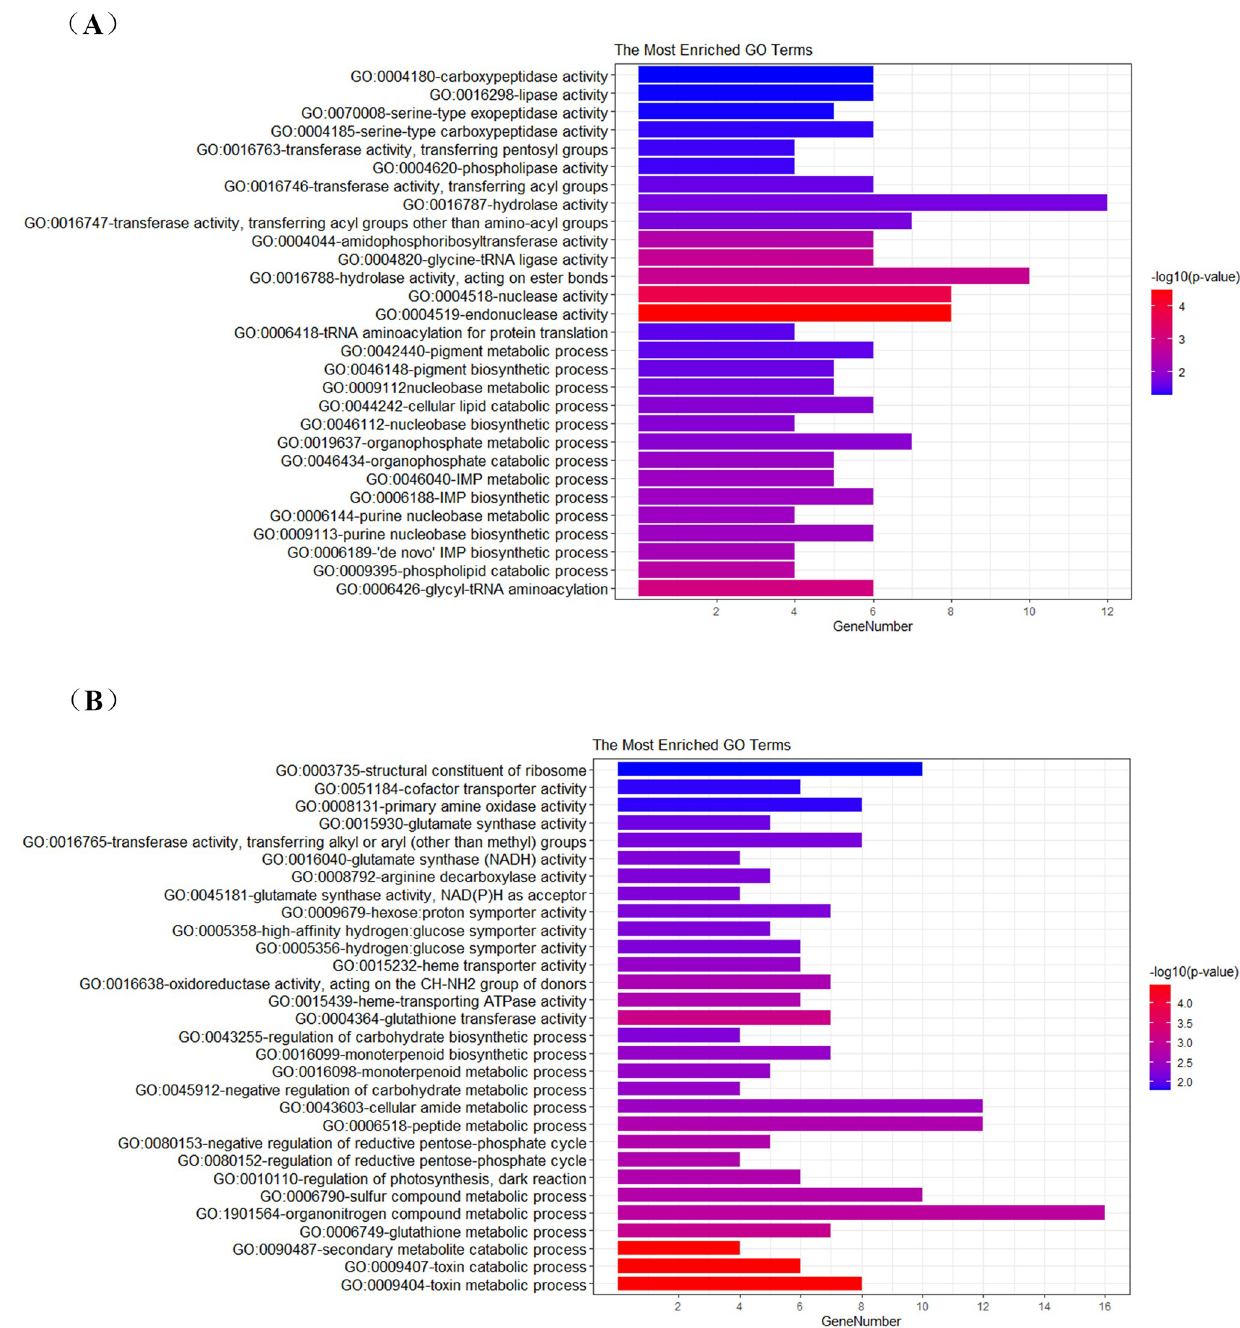
Fig 1. The most enriched terms in the GO analysis for upregulated genes (A) and downregulated genes (B). In the diagram, the most enriched GO terms were left-listed, and GeneNumber denoted the number of genes inupregulated/downregulated cDEGs (as a gene set) that have the corresponding GO functional annotation. The right color gradient represented -log 10 ( p -value) of upregulated/downregulated cDEGs enriching in each GO term.